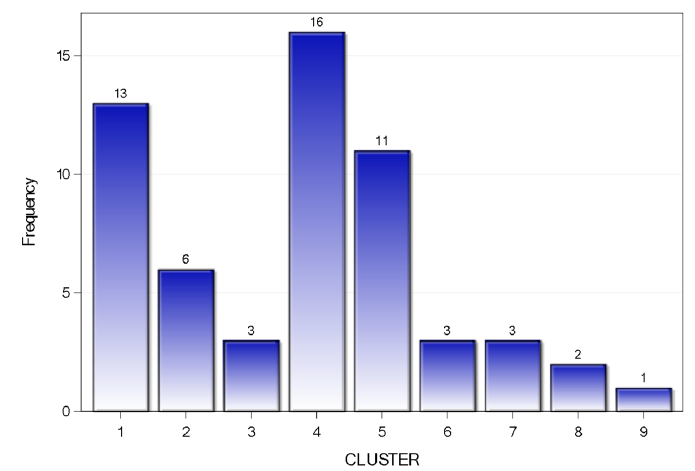
Figure 5. Pie Chart of Clusters. J. Risk Financial Manag. 2019 , 12 , x FOR PEER REVIEW